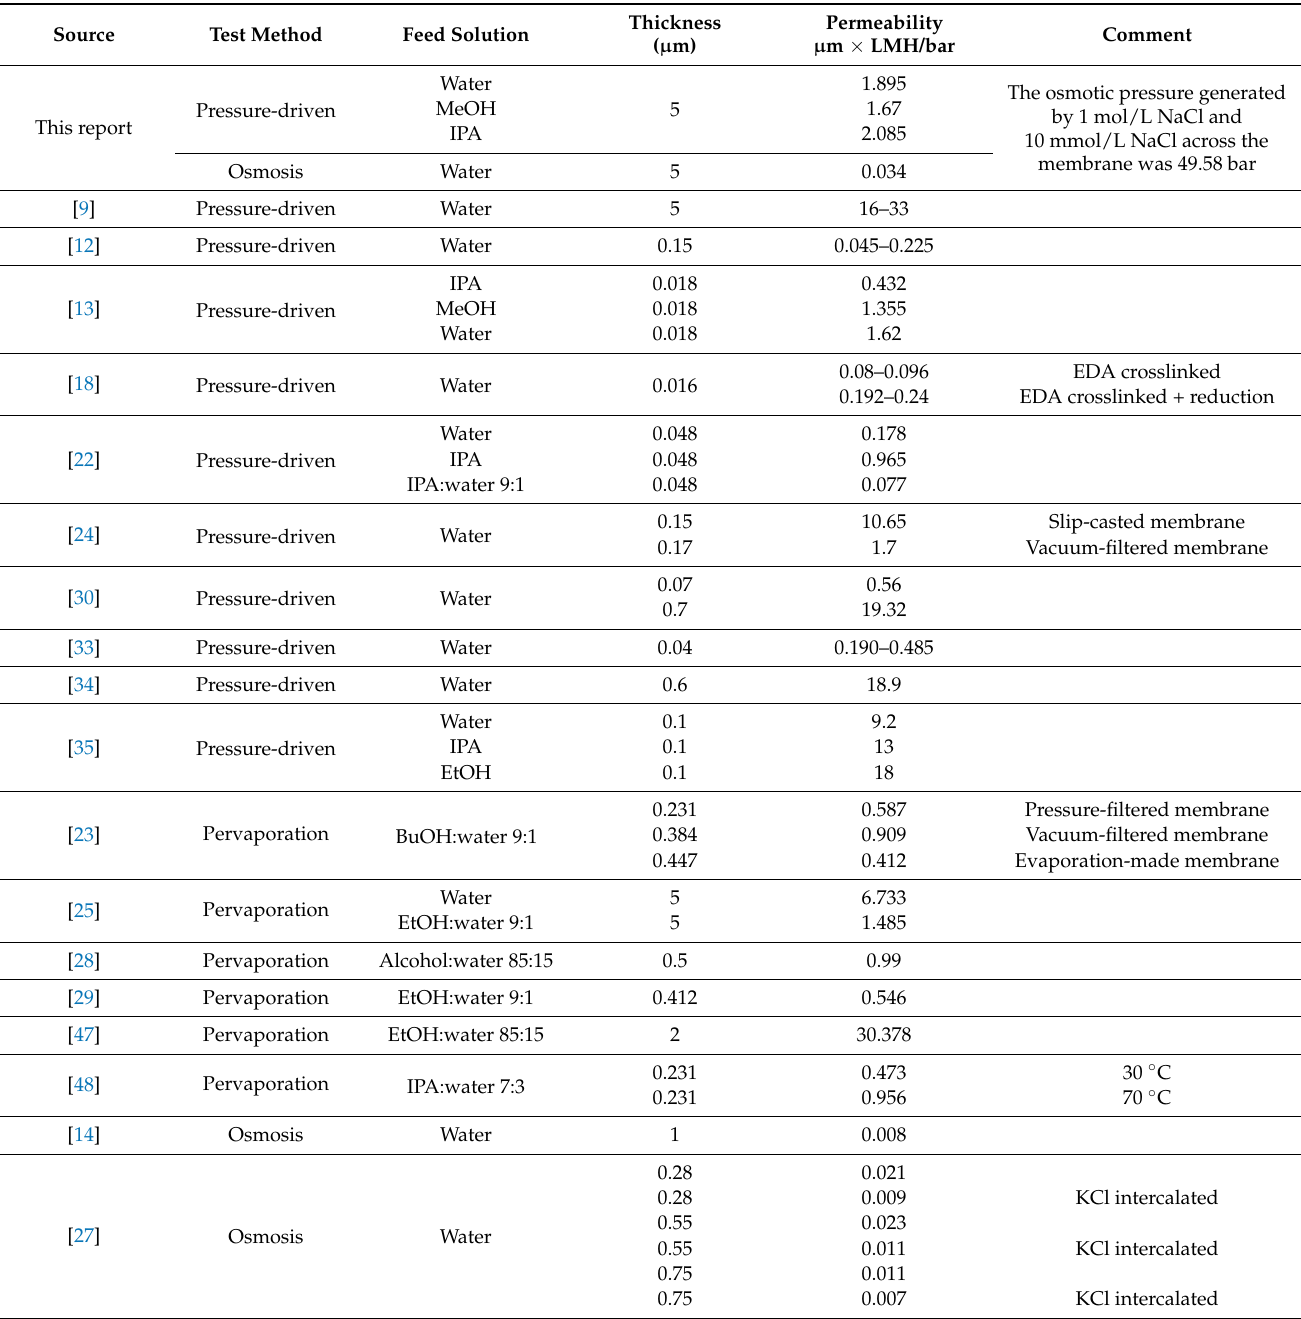
Table 1. Literature reports of GO membrane